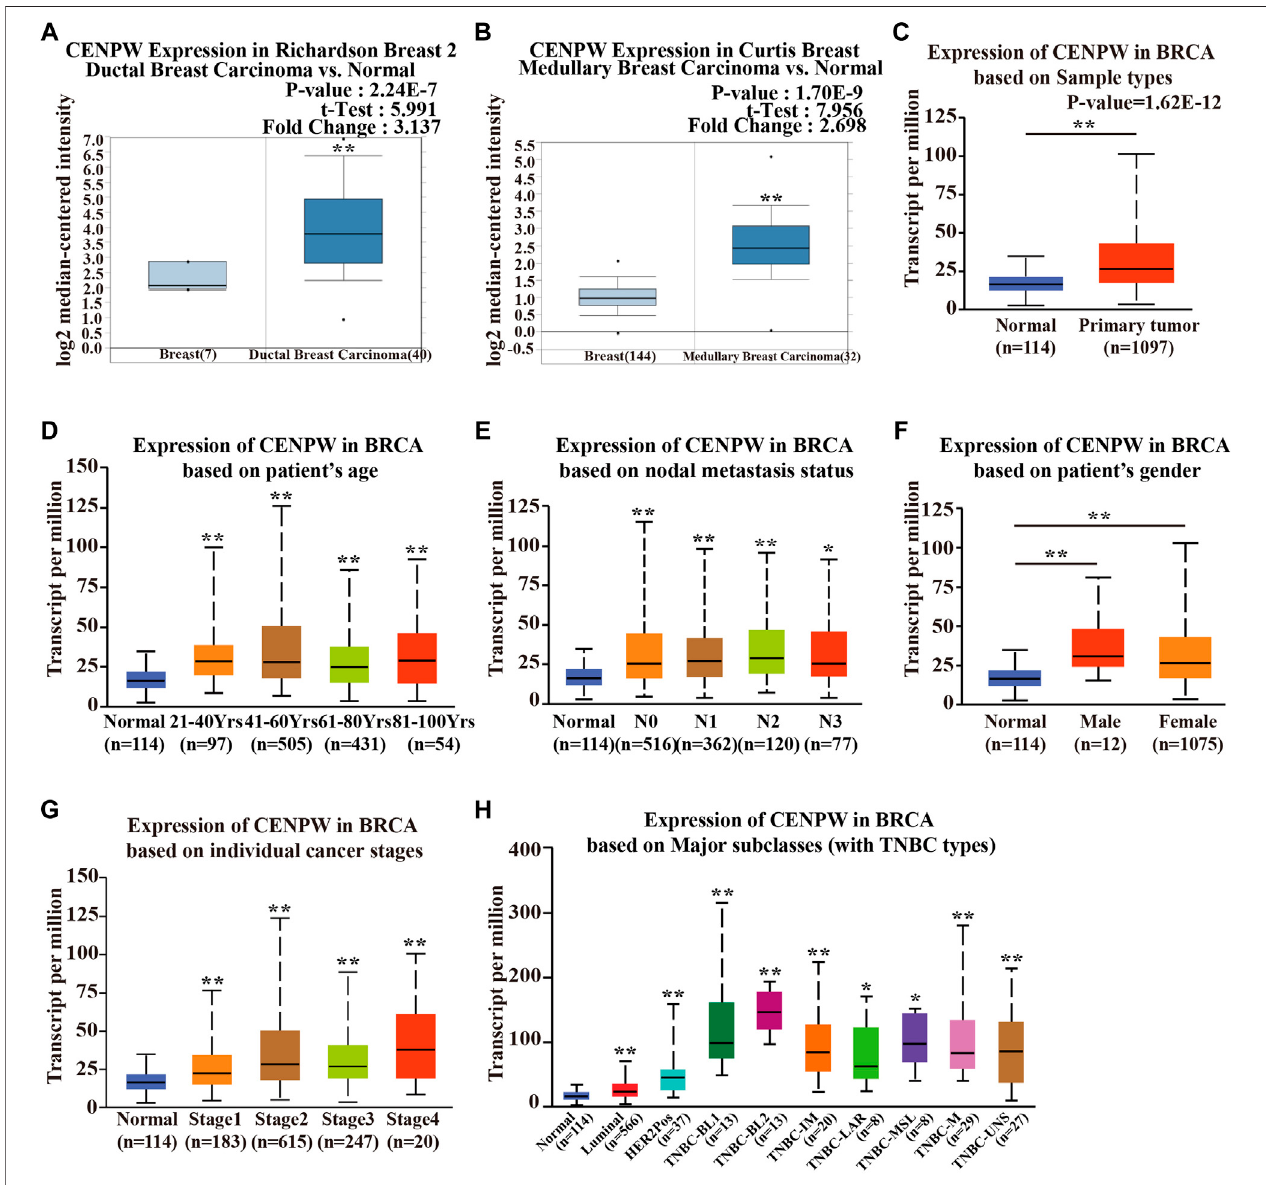
FIGURE2| The CENPW expressioninmultiplesubtypesofbreastcarcinoma.Expressionlevelsof CENPW in (A) ductalbreastcarcinomaand (B) medullarybreast carcinoma. (C) The CENPW expression in multiple subtypes of BRCA compared to normal samples derived UALCAN cancer database. Box plots of CENPW mRNA levels in the UALCAN cancer database based on (D) patient ’ s age, (E) gender, (F) nodal metastasis status, (G) individual cancer stages and (H) major subclasses (with TNBC types) of breast cancer patients were shown. * p < 0.05, ** p < 0.01 compared with control group.